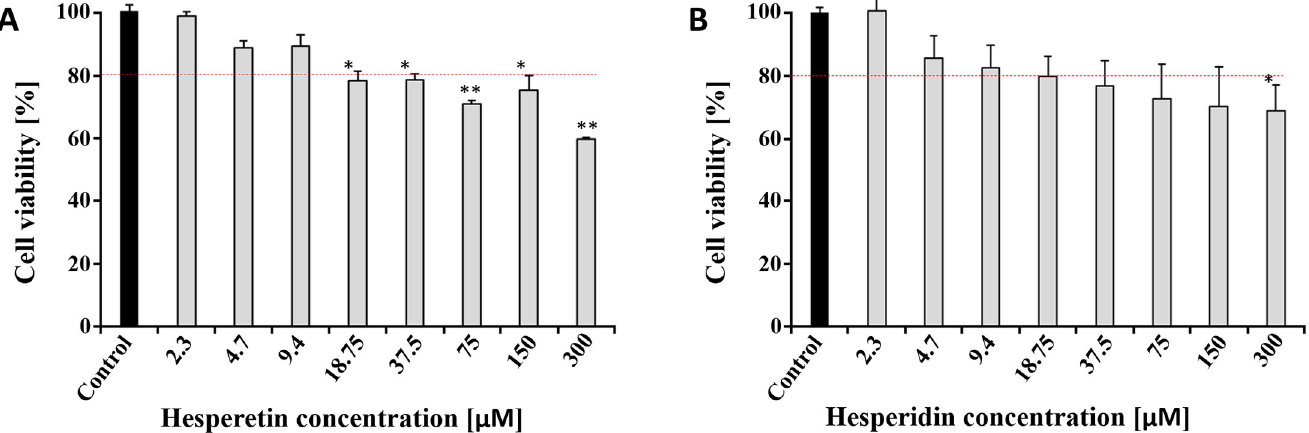
Fig 8. MTT assay of HST and HSD on Vero cells. MTT assay was used to evaluate the cytotoxicity of the two compounds. Different concentrations up to 300 µ M were used to treat the Vero cells for 2 days. Data shown are the means ± SD from three independent measurements (n = 3). Asterisk means the data differed from the control (0 µ M) significantly at p < 0.05 ( � ) and at p < 0.01 ( �� ), level according to ANOVA and Tukey’s test. A: Hesperetin and B: